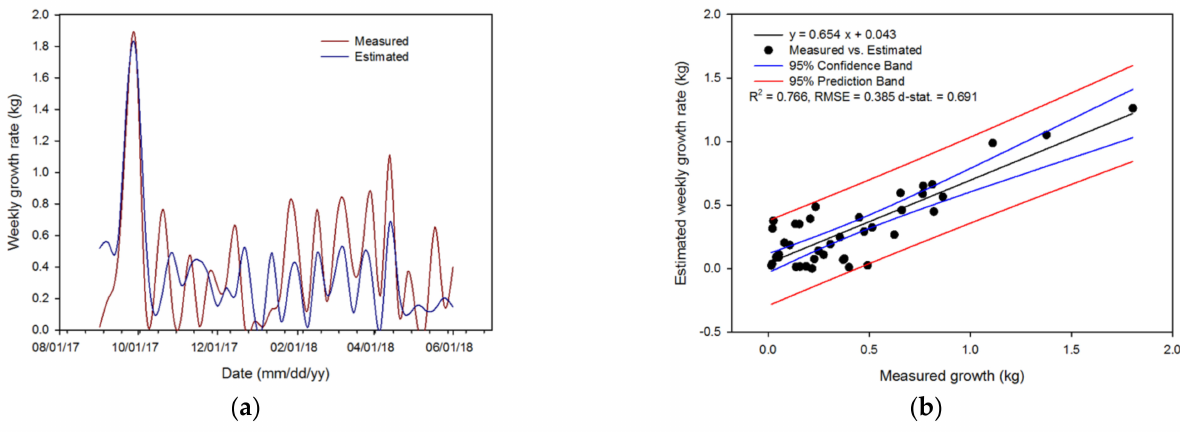
Figure 9. Comparison of the weekly crop growth rates measured by the fresh weight measuring system and estimated by the recurrent neural network (RNN) algorithm during the growth period from 1 August 2017 to 1 June 2018 for validation cultivation ( a ). The test accuracies of the algorithms ( b